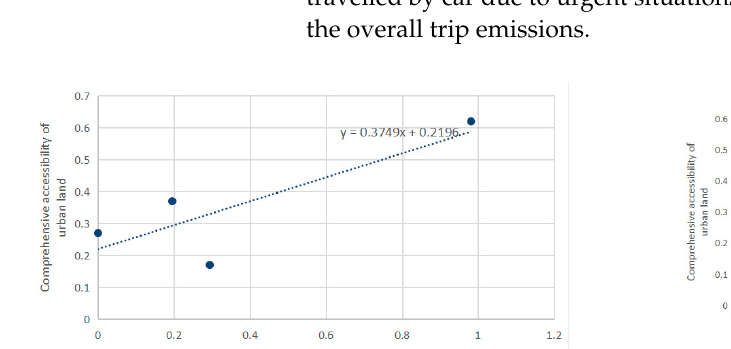
( e ) Figure 10. ( a ) Correlation between average single trip carbon emissions of kindergartens and comprehensive accessibility, ( b ) Correlation between average single trip carbon emissions of primary schools and comprehensive accessibility, ( c ) Cor- relation between average single trip carbon emissions of middle schools and comprehensive accessibility, ( d ) Correlation between average single trip carbon emissions of high schools and comprehensive accessibility, ( e ) Correlation between average single trip carbon emissions of other schools and comprehensive accessibility. When it comes to middle schools, high schools and other education facilities, parents care more about teaching quality than their locations. Many middle school students and high school students live at schools, which lowers commuting frequency. Therefore, edu- cation facilities with higher accessibility have low single trip carbon emissions. 6.3. Correlation between Carbon Emissions of Trip on Medical Care Facility and Accessibility Average carbon emissions of a single trip on medical care facilities were calculated and classified by categories as hospitals and primary medical and health institutions. Comprehensive accessibility and single trip carbon emissions were plotted as scatter dia- gram. And the trend line was drawn by least square method.